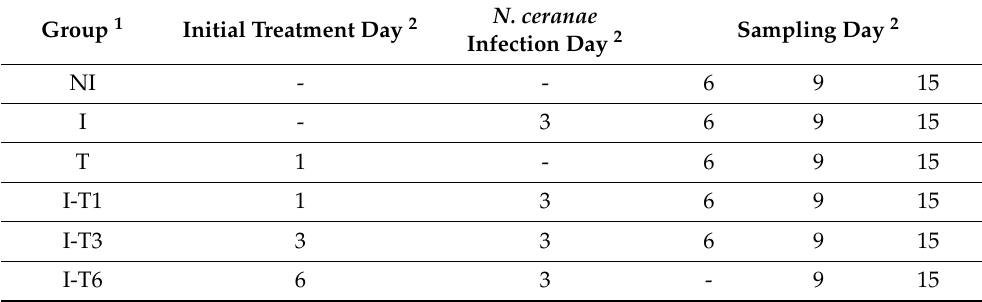
Table 1. Experimental